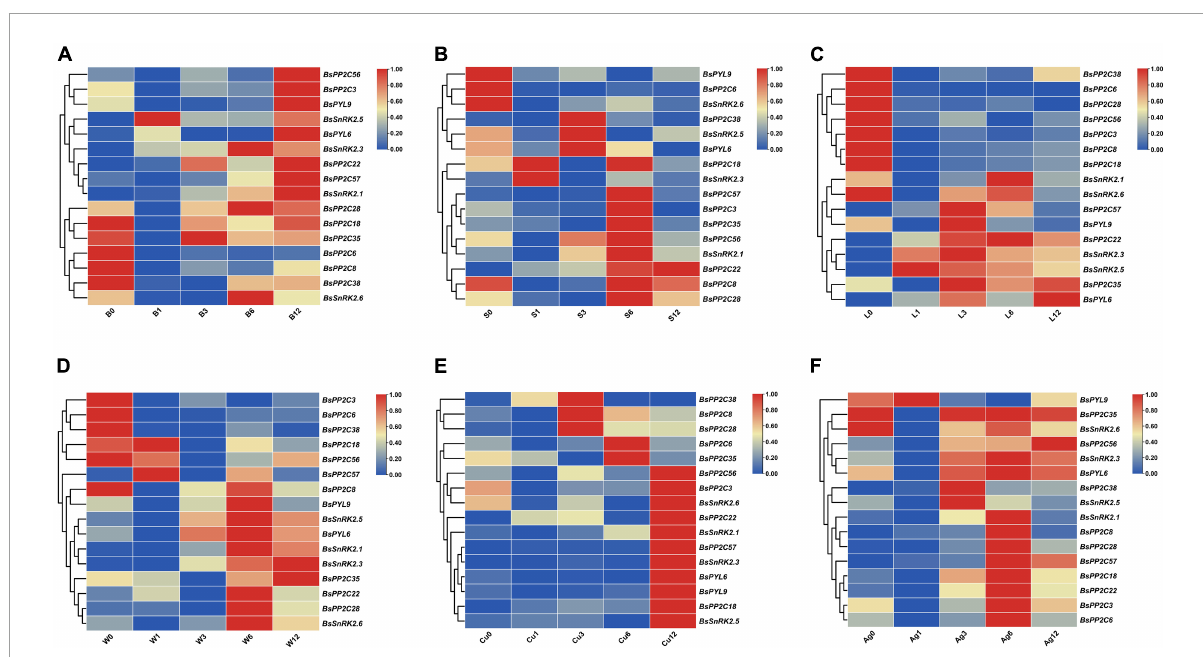
FIGURE5 Expression profile heatmap with hierarchal clustering of selected two BsPYLs, ten BsPP2Cs, and four BsSnRK2s genes in response to different stress treatments for 0, 1, 3, 6, and 12 h, including ABA ( A , B0–B12), SA ( B , S0–S12), low temperature ( C , L0–L12), wounding ( D , W0–W12), CuSO 4 ( E , Cu0–Cu12), and AgNO 3 ( F , Ag0–Ag12). The relative expression for each genes is depicted by color intensity in each field. Higher values are represented by red whereas lower values are represented by blue.